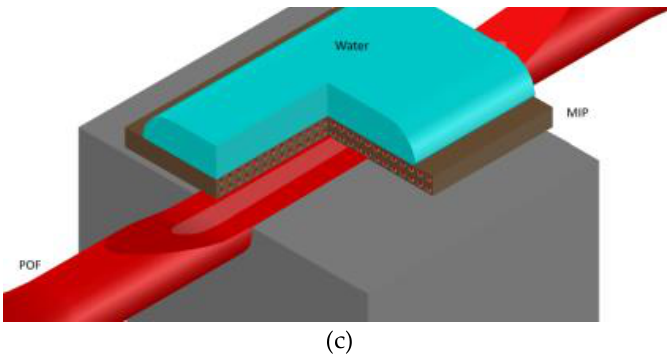
Figure 1. POF sensor: ( a ) picture of the D-shaped POF sensor platform; ( b ) typical SEM image of the optical platform; ( c ) sensing region outline of a D-shaped POF with an MIP receptor.